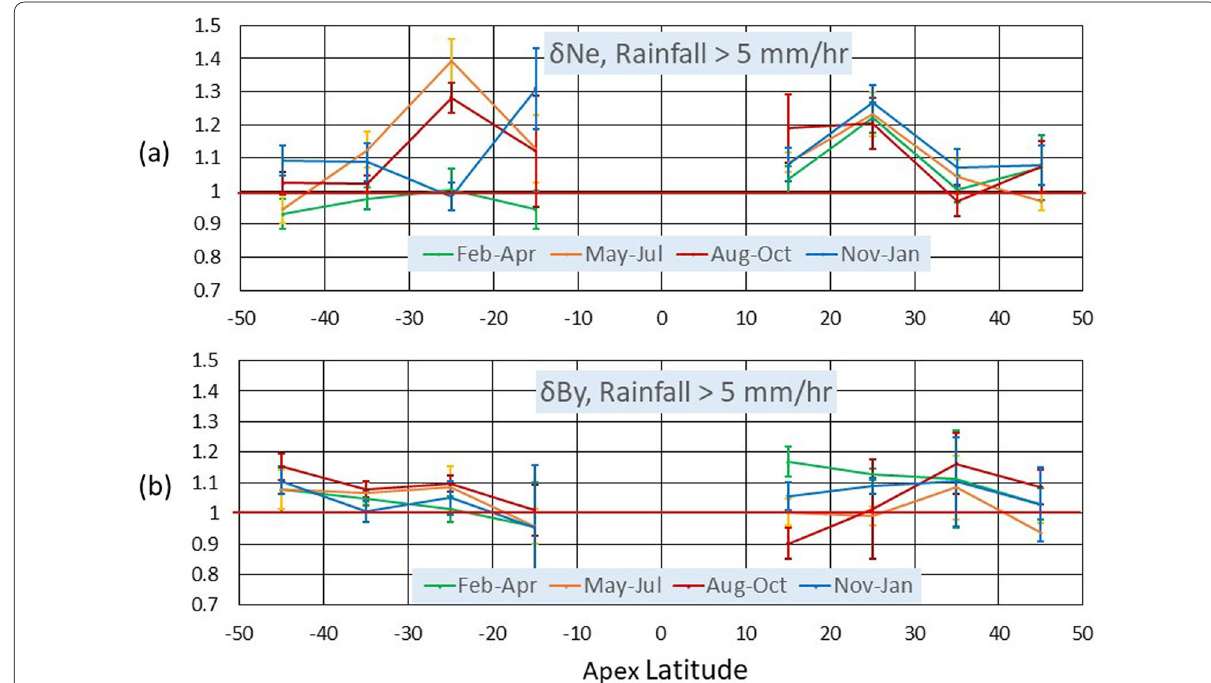
Fig. 10 a Longitudinally averaged amplitude ratios of electron density fluctuations and b By-component of magnetic ripples for each season. The GSMaP data at the same geodetic latitude and longitude with the satellite location, i.e., P0 in Fig. 1, are used in this